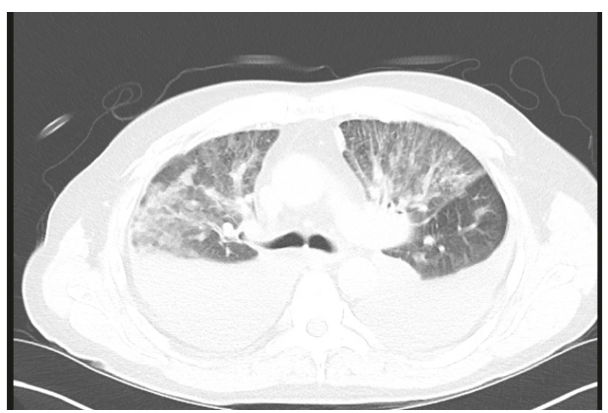
Figure 1: CT of the chest without contrast shows prominent parenchymal ground-glass changes. Large bilateral pleural effusions and moderate pericardial effusion.